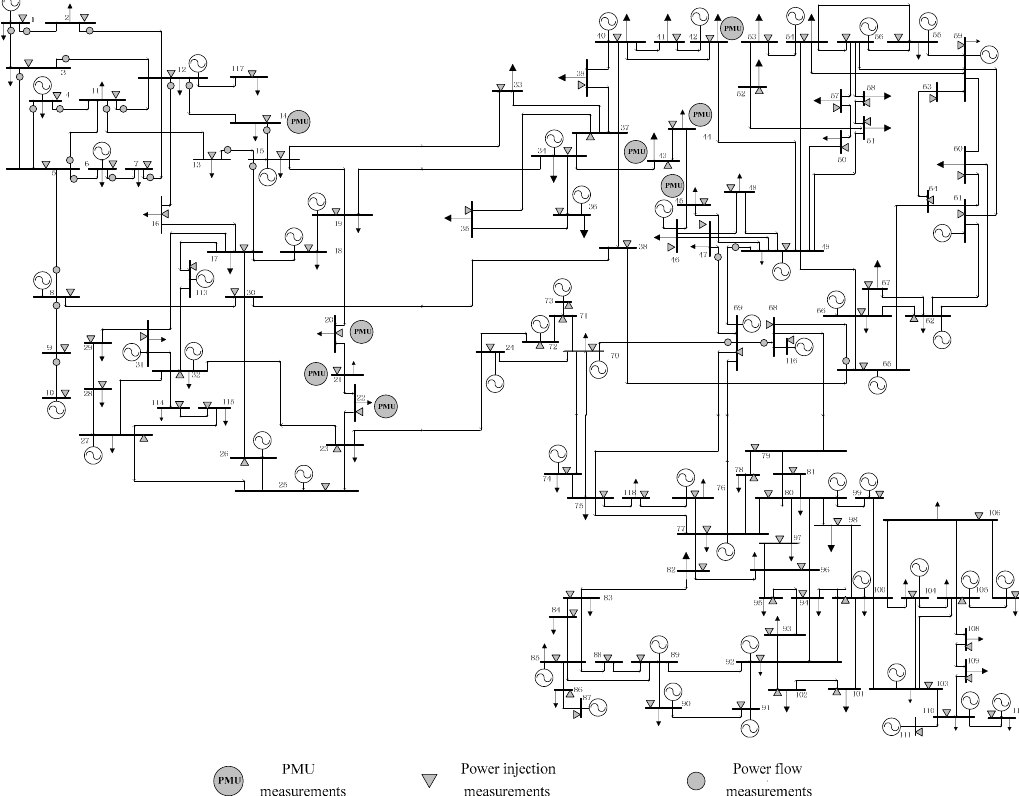
Figure 17. Simulation measurement configuration of the IEEE 118 bus system.